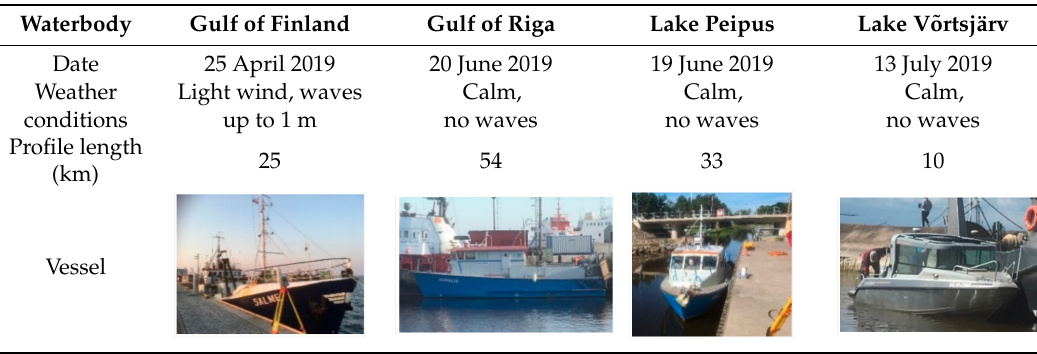
Figure 5. Research vessel SALME ( a ) and the GNSS receivers on top of the wheelhouse ( b ). The total station ( a ) was used to connect the GNSS antenna’s reference point with sea level. Table 2. General parameters of the GNSS kinematic